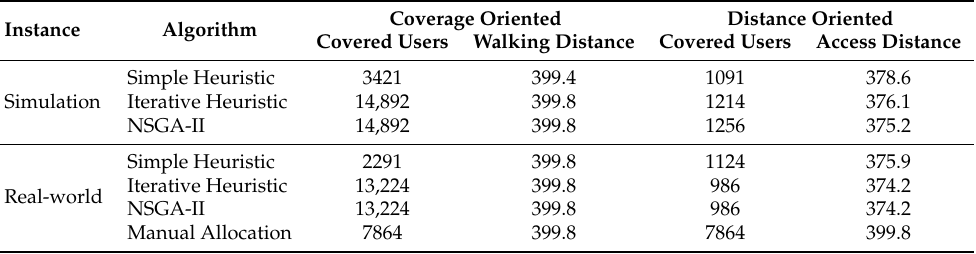
Table 10. Comparing the best results from each algorithm categories and manual allocation in MU1